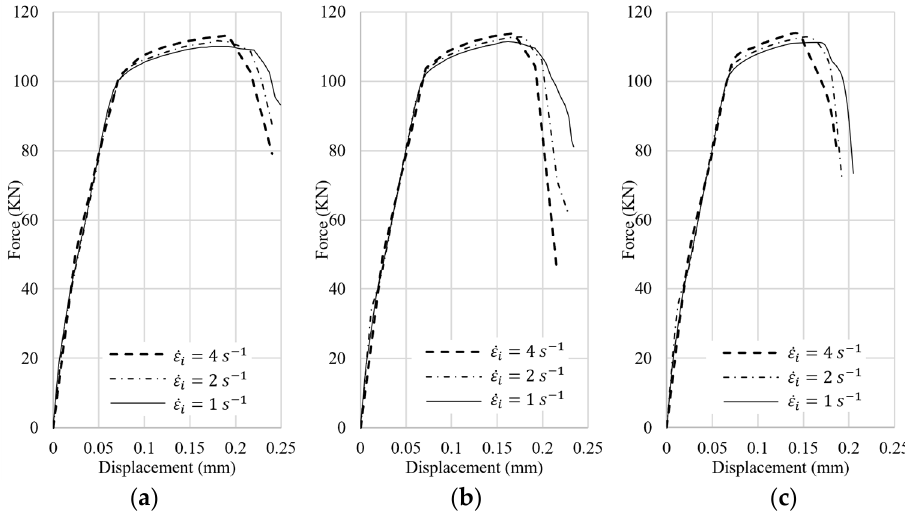
Figure 22. Force–displacement curves of ( a ) 3by3 models, ( b ) 6by6 models and ( c ) 18by18 models.